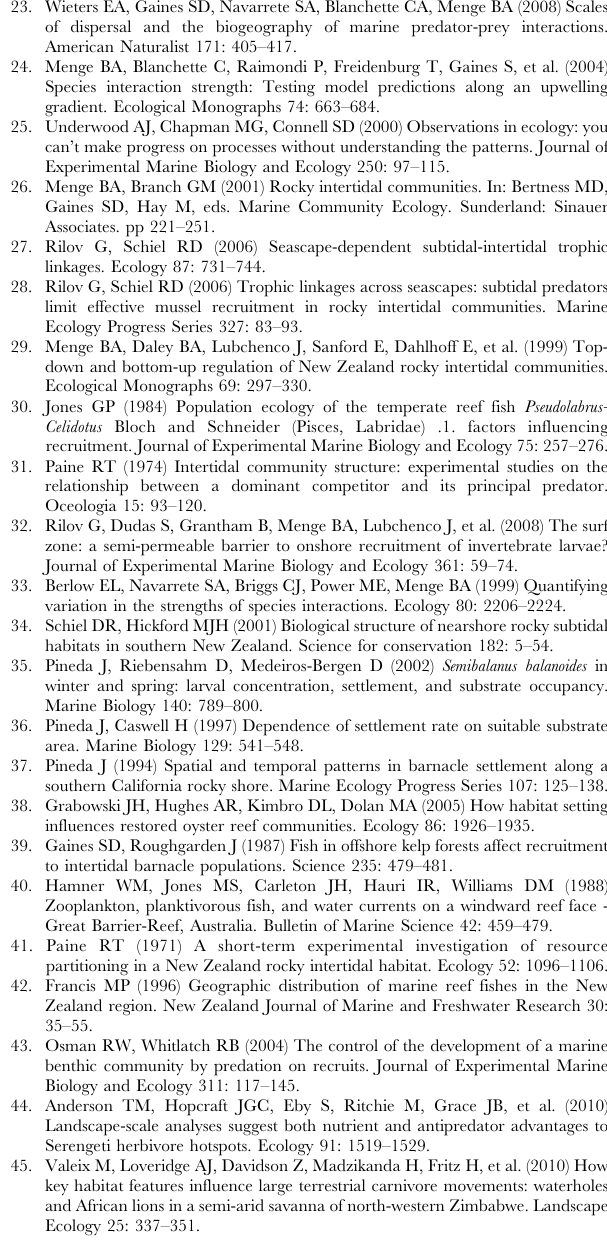
Table S2 Number of invertebrate macro-predators (whelks and sea stars) on rock surface (within 20 6 30 cm quadrats, numbers extrapolated to 1 m 2 ) in the low and mid shore levels, and within low shore crevices (per 10 min. search time). Surveys were conducted in the North Island on August 3, 2004, and the South Island on September 20, 2004. (DOC) Table S3 Fish abundance (per 15 min. swim per site) and visitation (mean ± SD of three 5 min. observations of an area c 20 m 2 near experimental plots) and feeding activity rates (mean ± SD of three 5 min. observations near experimental plots) at the four Mt. Maunganui